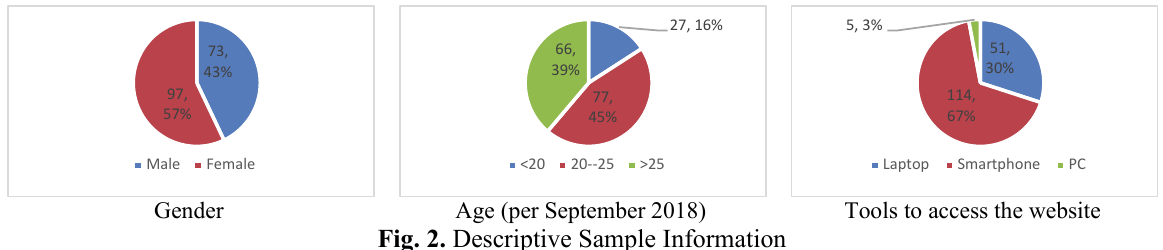
Fig. 2. Descriptive Sample